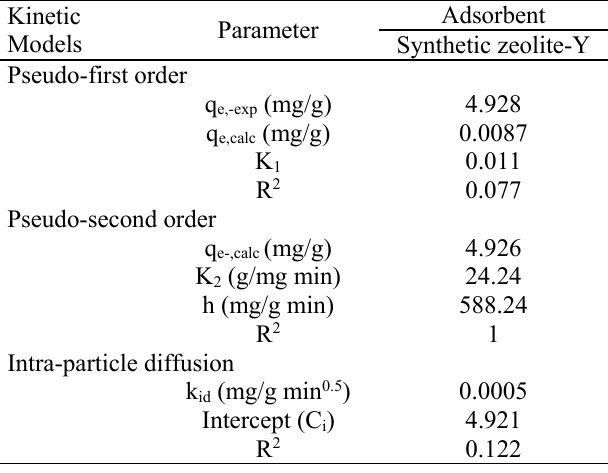
Kinetic parameters for pseudo-first, second-order and intra- particle diffusion adsorption kinetic models of Cd 2+